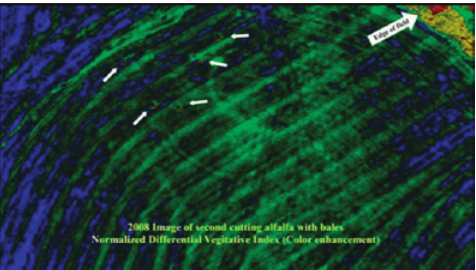
Fig. 11. Multispectral images: (Wikipedia 2011)